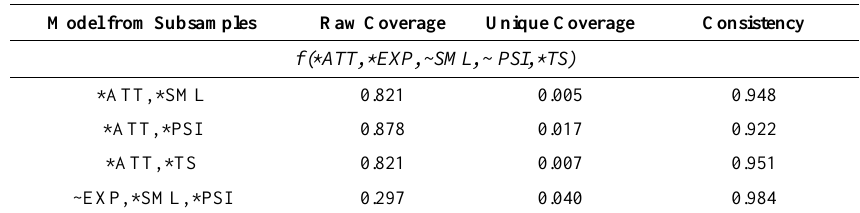
Table 12. Solutions from the